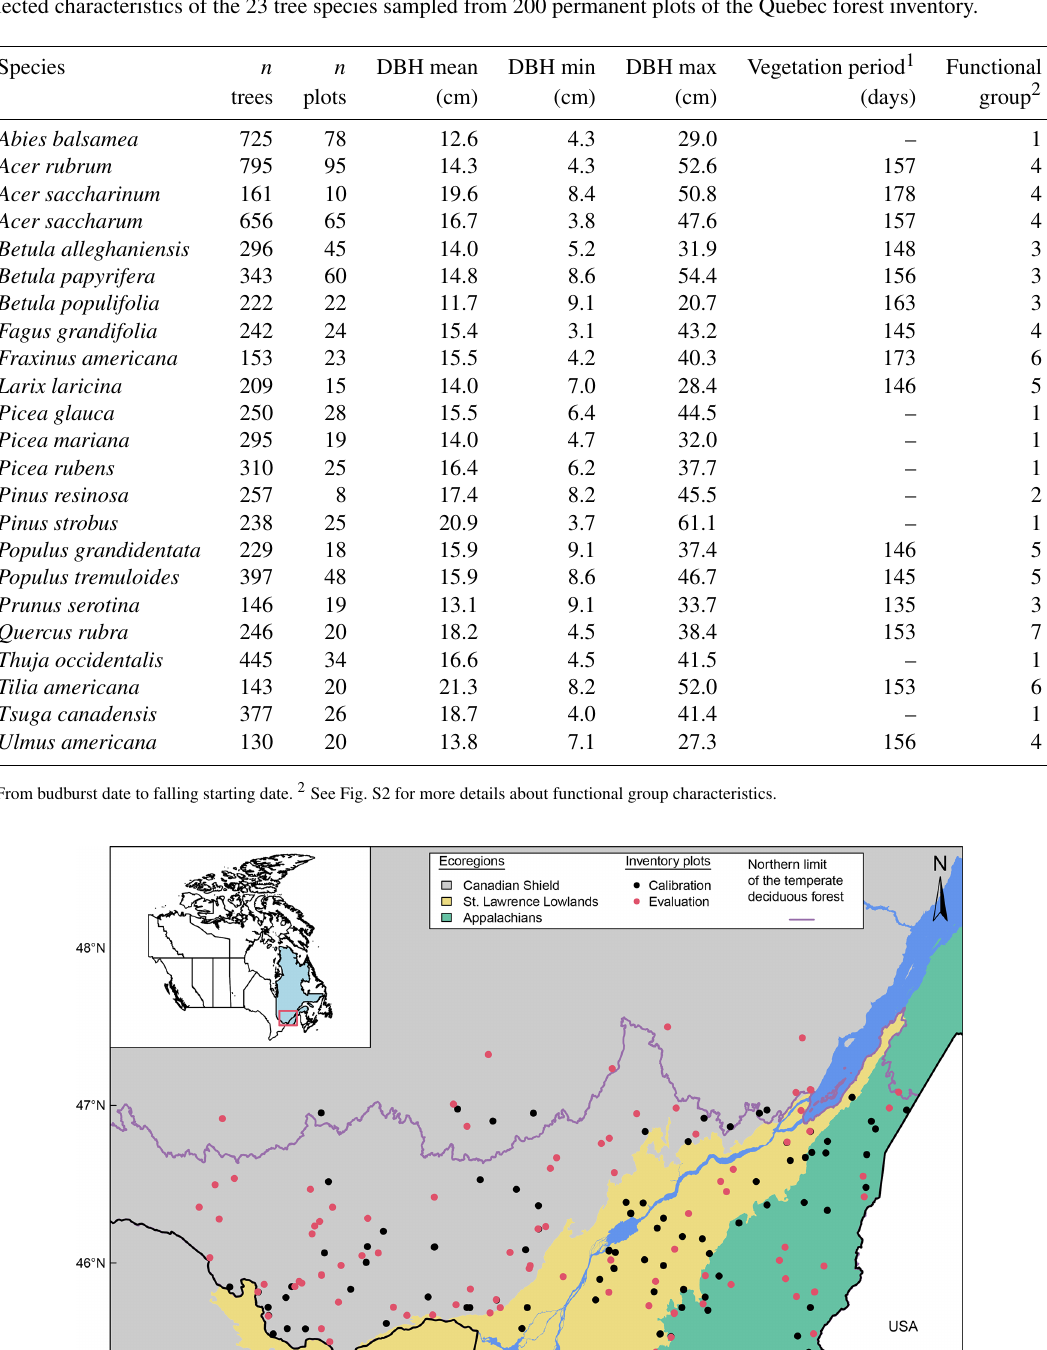
Table 1. Selected characteristics of the 23 tree species sampled from 200 permanent plots of the Quebec forest inventory. Species n n DBH mean DBH min DBH max Vegetation period 1 Functional trees plots (cm) (cm) (cm) (days) group 2